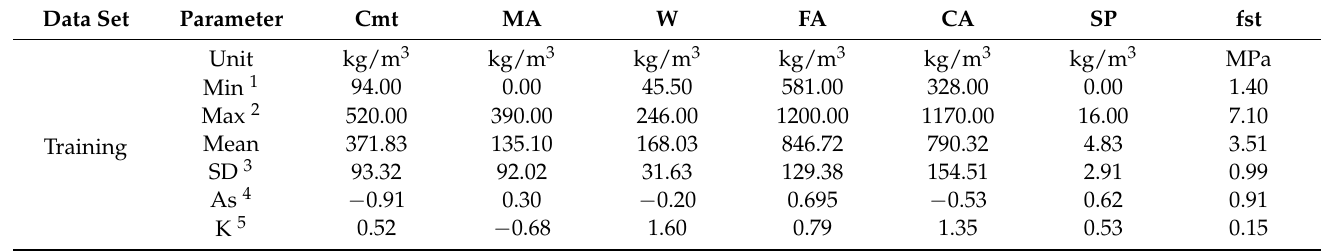
Table 3. Minimum, maximum, mean, standard deviation, skewness, and kurtosis of input and output variables for each data set.